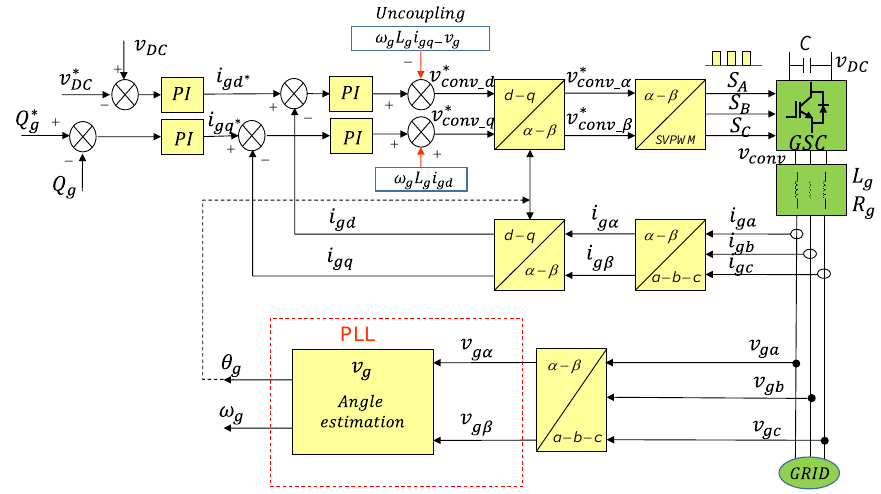
Figure 4. Grid side converter control structure.